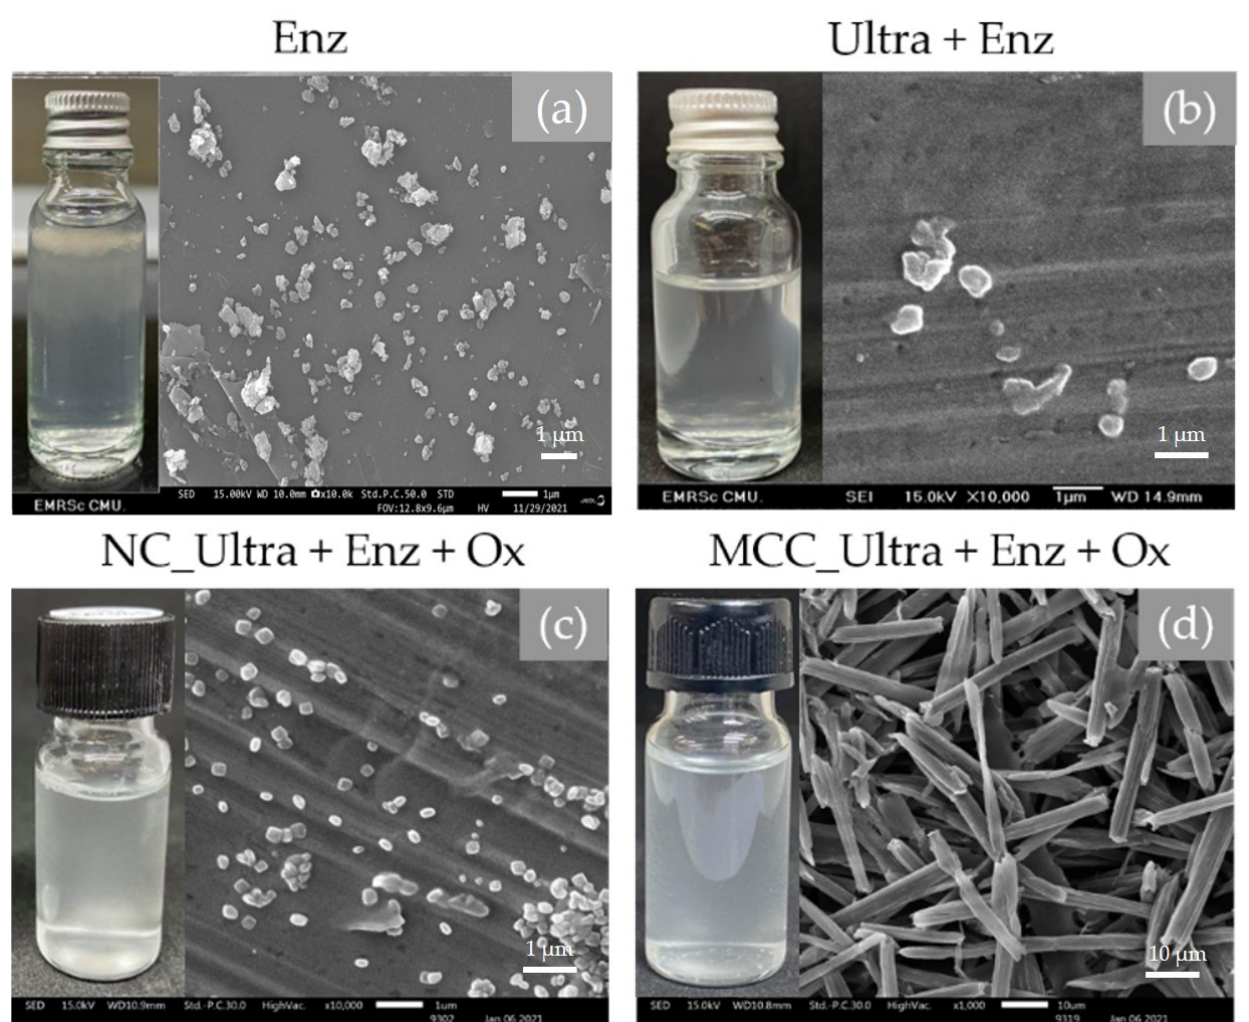
Figure 4. Appearances and SEM micrographs of nanocellulose suspensions obtained from rice straw cellulose hydrolysis via integrated biobased approaches of ( a ) enzymatic hydrolysis (Enz), ( b ) ultrasonication prior to enzymatic hydrolysis (Ultra + Enz), and ( c ) intensification by oxalic acid hydrolysis (NC_Ultra + Enz + Ox) (at 10,000×) and ( d ) microcrystalline cellulose of remaining rice straw cellulose (MCC_Ultra + Enz + Ox)(at 1000×).